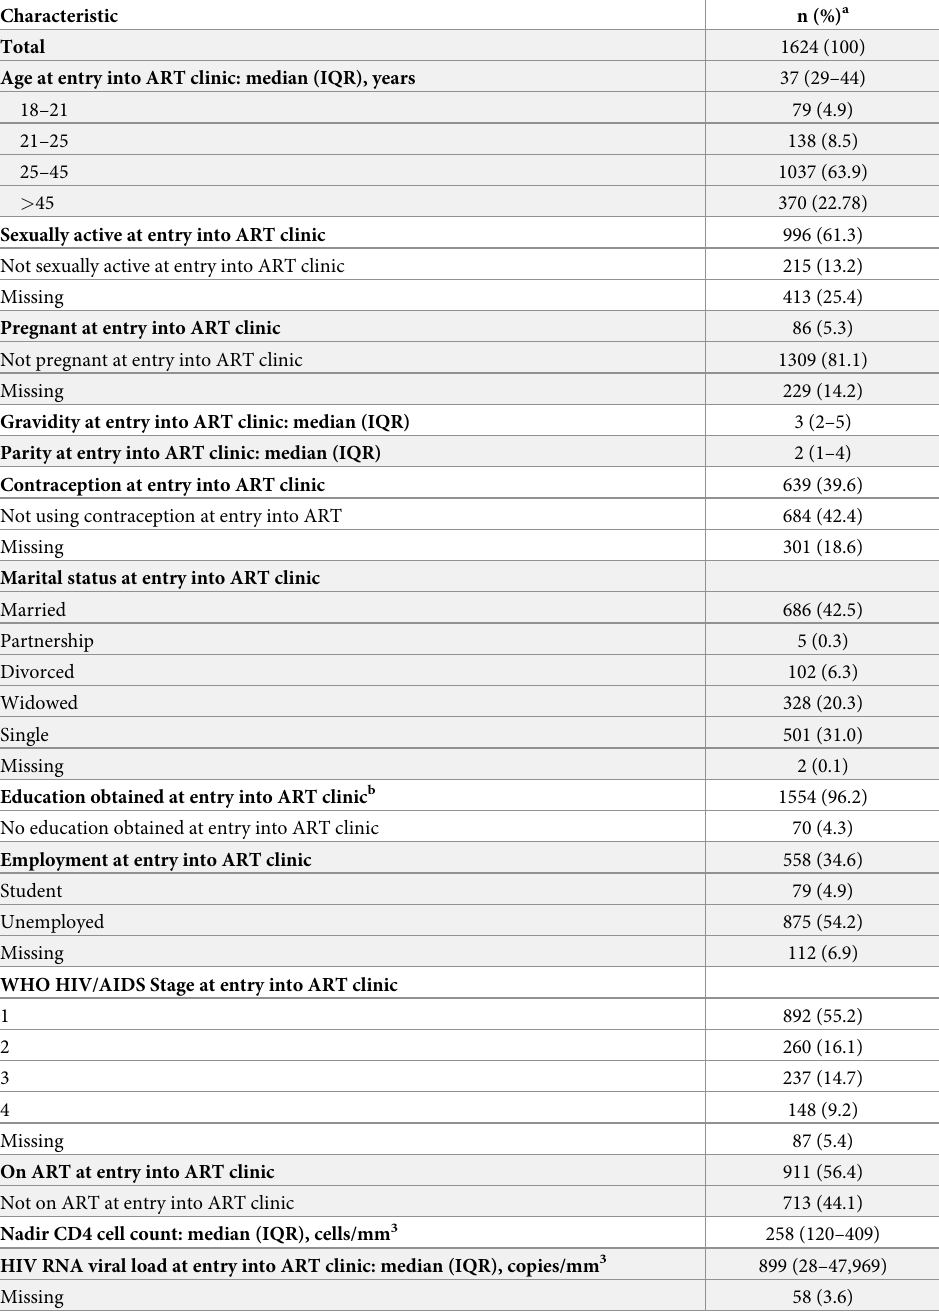
Table 1. Patient characteristics at